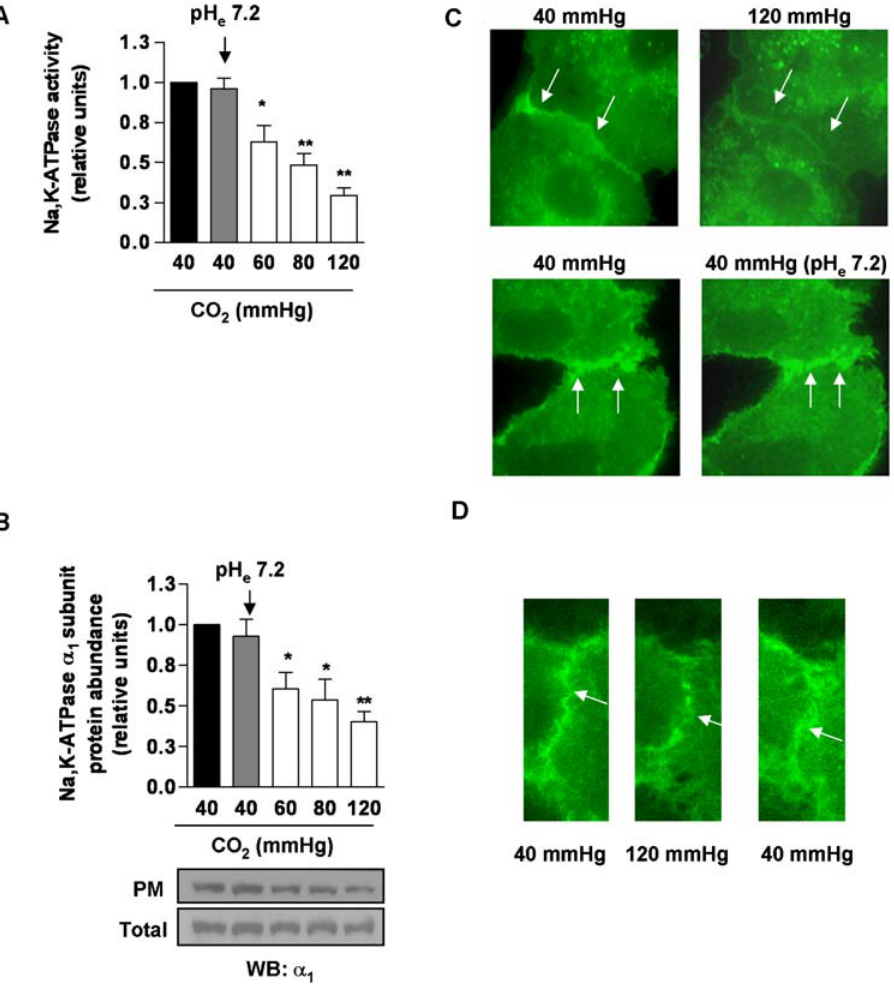
Figure 3. High CO 2 levels impair Na, K-ATPase activity independently of pH. (A) ATII cells were exposed to 40, 60, 80 and 120 mmHg CO 2 with extracellular pH (pH e ): 7.4 or to 40 mmHg CO 2 with pH e : 7.2 for 30 min, and Na,K-ATPase activity was measured as [ c - 32 P]ATP hydrolysis. Graph represents the mean 6 SEM, (n=5). (B) ATII cells were treated as described in (A) and the Na,K-ATPase protein abundance at the plasma membrane (PM) was determined by biotin-streptavidin pull down and subsequent Western blot. Graph represents the mean 6 SEM, (n=5). Representative blots of Na,K-ATPase a 1 -subunit at the PM and total protein abundance are shown. (C) Live cell imaging of GFP a 1 -A549. Cells were exposed to 40 mmHg CO 2 (pH e : 7.4) for 10 min (left panels) and then switched to 120 mmHg CO 2 (pH e : 7.4) (right, upper panel) or to 40 mmHg CO 2 (pH e : 7.2) (right, lower panel) for 30 min. White arrows indicate the plasma membrane Na,K-ATPase. (D) Live cell imaging of GFP a 1 -A549. Cells were exposed to 40 mmHg CO 2 (pH e : 7.4) for 10 min (left panel), switched to 120 mmHg CO 2 (pH e : 7.4) (middle panel) for 30 min and switched back to 40 mmHg CO 2 (pH e : 7.4) for 60 min (left panel). White arrows indicate the plasma membrane Na,K-ATPase * p , 0.05, ** p ,